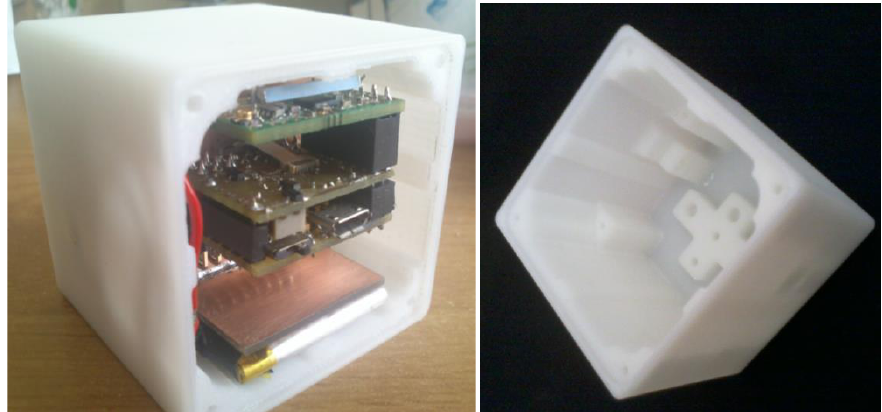
Figure 8. Tilt sensor with 3D-printed housing and wireless transmission.